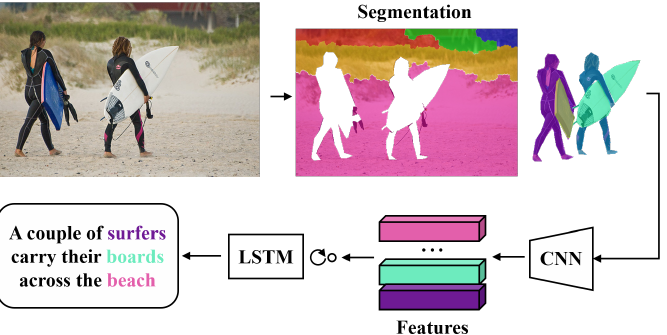
Figure 1. An overview of our proposed method. Given an image, we first generate segmentation regions of the image and use a convolutional neural network to extract the segmentation-region features. For readability, we have applied a color map to each segment. The segmentation-region features are then fed to the LSTM to generate the